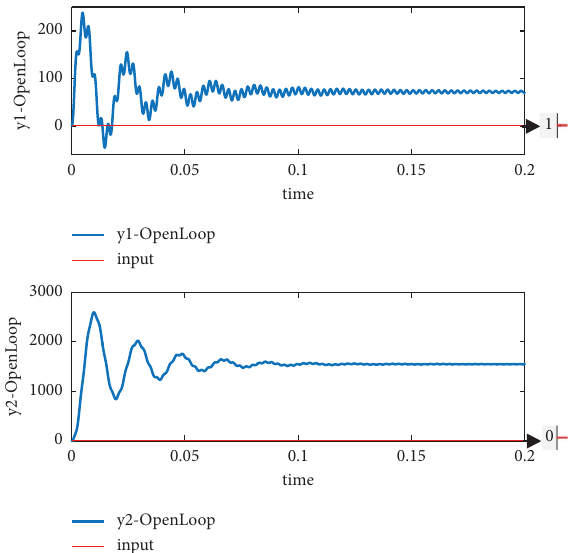
Figure 5: System response in the frst mode to input [ u ] T � [1 0].